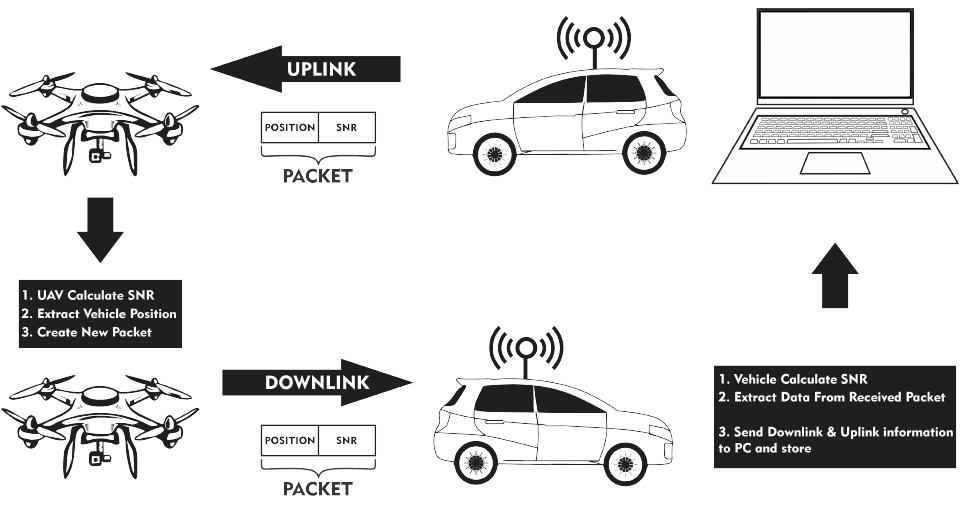
Figure 3. Transmission setup.